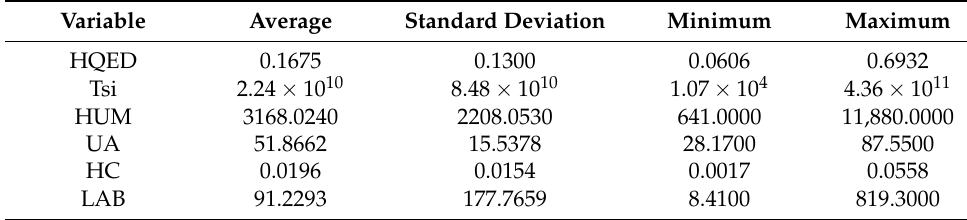
Table 4. Data sources and definition of variables and descriptive statistics.